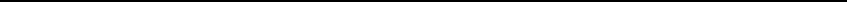
Fig. 4 Silencing NatD suppresses cancer cell EMT by downregulating Slug. a Representative phase contrast images of Scr and NatD-KD H1299 cells treated with TGF- β 1. Data are representative of three independent experiments. Scale bar, 100 μ m. b Quantitative real-time PCR analysis of mRNA levels of indicated key EMT-related genes in Scr and NatD-KD H1299 cells normalized to GAPDH in the absence or presence of TGF- β 1. Results are shown as mean ± s.d. of three independent experiments. Two-tailed Student ’ s t -test was used. ** P < 0.01 or * P < 0.05 compared with the indicated control. c Western blot analysis of indicated protein levels in Scr and NatD-KD H1299 cells in the absence or presence of TGF- β 1. GAPDH served as a loading control. Data are representative of three independent experiments. d Immuno fl uorescence analysis of Scr and NatD-KD H1299 cells in the absence or presence of TGF- β 1 stained for E-cadherin and N-cadherin. Data are representative of three independent experiments. Scale bar , 20 μ m. Migration ( e , top ) and invasion ( f , top ) of Scr cells, NatD-KD cells, and NatD-KD cells with enforced Slug expression (NatD-KD + Slug). ( bottom panels ) Cells were counted in at least four random microscope fi elds (×100 magni fi cation) for the corresponding assays; migration and invasion are expressed as a percentage of control. Results are shown as mean ± s.d. of three independent experiments. Two-tailed Student ’ s t -test was used. ** P < 0.01 compared with the indicated control. g Quantitative real- time PCR analysis of the mRNA levels of NatD and indicated key EMT-related genes (normalized to GAPDH ) in Scr cells, NatD-KD cells, and NatD-KD + Slug cells. Results are shown as mean ± s.d. of three independent experiments. Two-tailed Student ’ s t -test was used. ** P < 0.01 or * P < 0.05 compared with Scr or indicated control. h Western blot analysis of indicated protein levels in Scr cells, NatD-KD cells, and NatD-KD + Slug cells. GAPDH served as a loading control. Data are representative of three independent blots. i Pearson correlation scatter plot of the H score of Slug and NatD in human lung carcinoma ( n = 147); r = 0.6672, P <